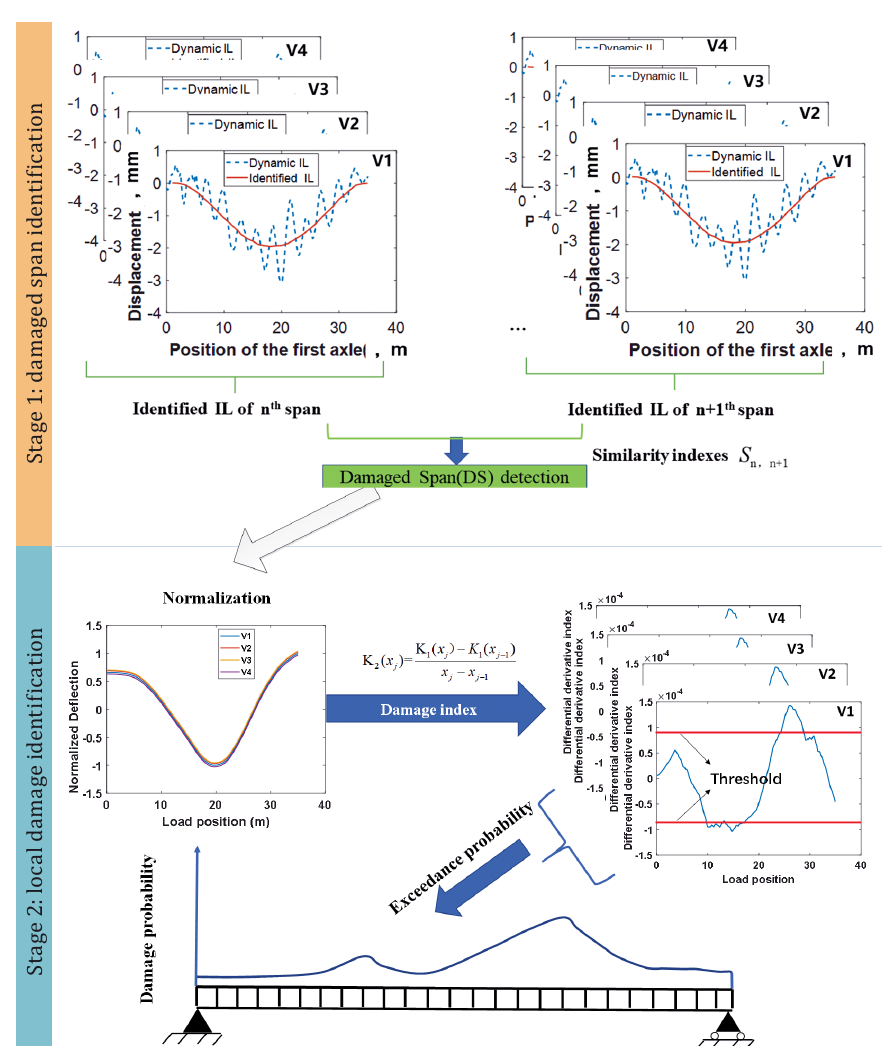
Figure 13. Flow chart of the two-stage damage identification